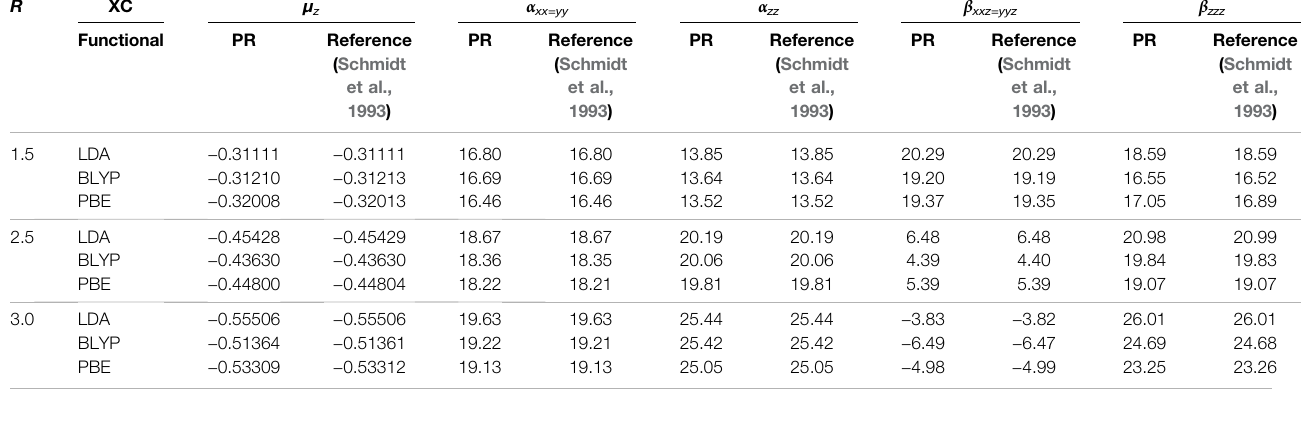
TABLE 5| Static dipole moment μ z , along with FF α , (cid:2) α , β (in a.u.) of HCl molecule at various distorted geometries. All quantities are in a.u. More details are available inGhosal et al. (2018). R XC μ z α xx = yy α zz Functional